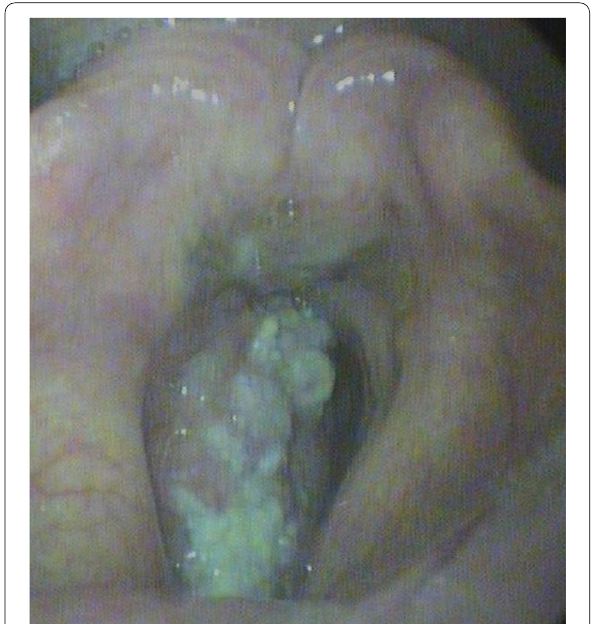
Fig. 1 Growth over the right ventricle, false and true vocal cord